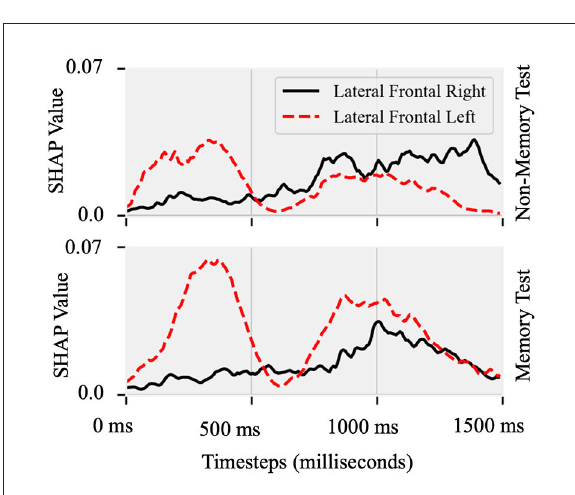
FIGURE5 Shapley values of EEG recorded from lateral-frontal left and right hemispheres Topographic plot as a function of time between the cue (0 ms) and target (1,500 ms) onset in the Non-Memory and Memory test paradigms. In both paradigms, predictability of stuttered or fluent speech was maximal after S1 onset at the left site and closer to S2 onset at the right hemisphere